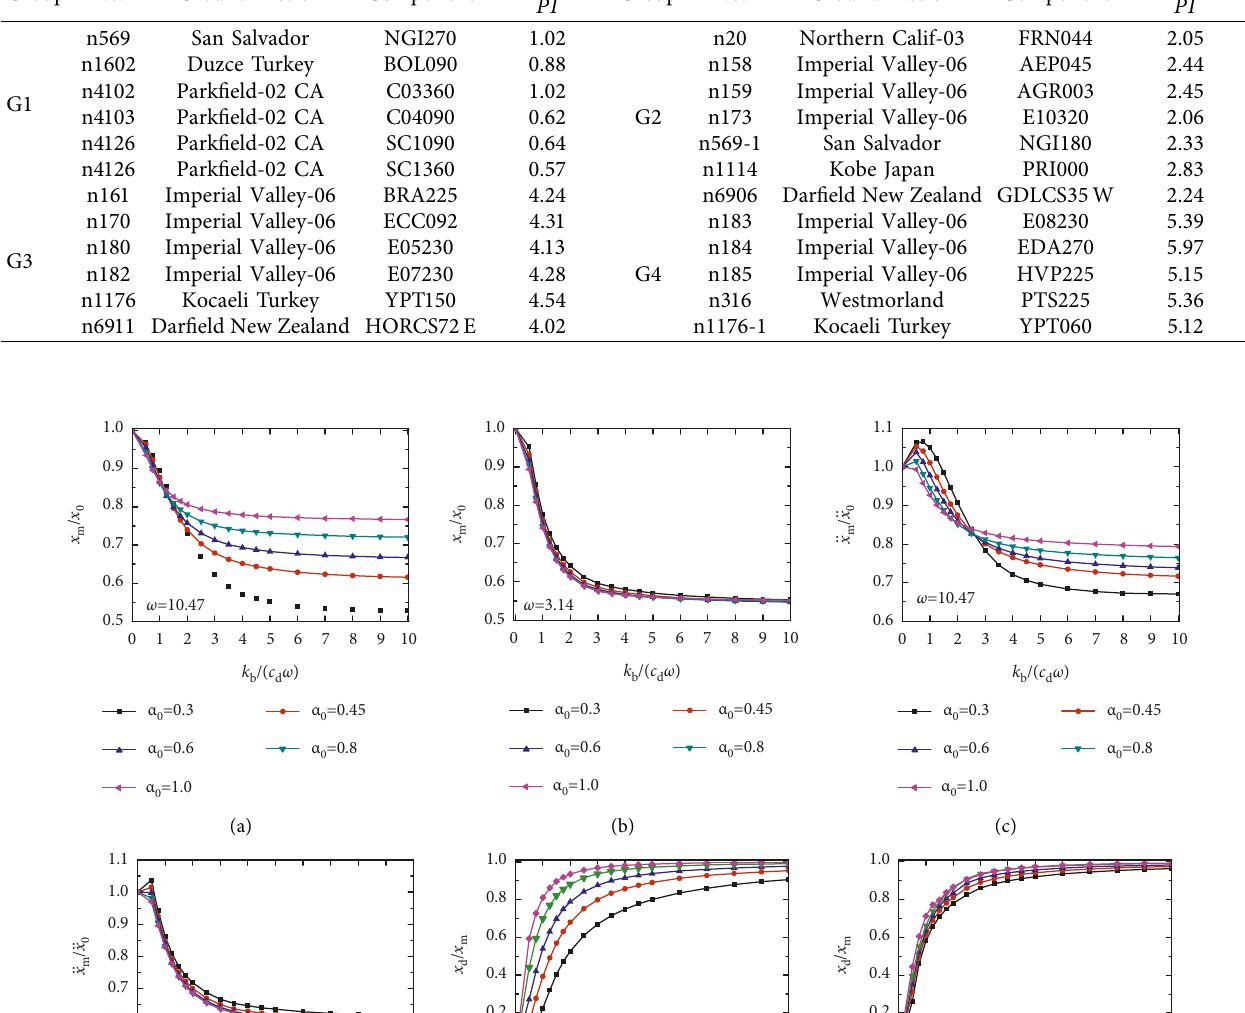
/ ( c ω ) and α on the seismic response of the SDOF structure ( β � 2) with periods T equals 0.6s and b d 0